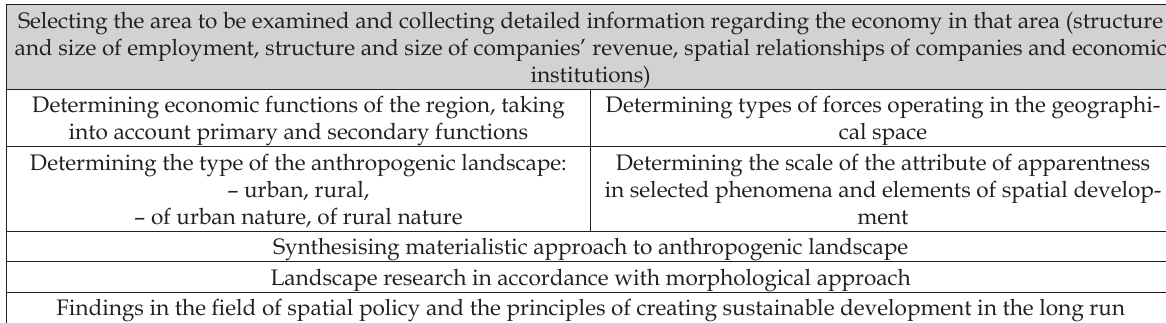
Table 1. The place of the physicalist approach in determining the nature of anthropogenic landscape in accord - ance with the materialistic